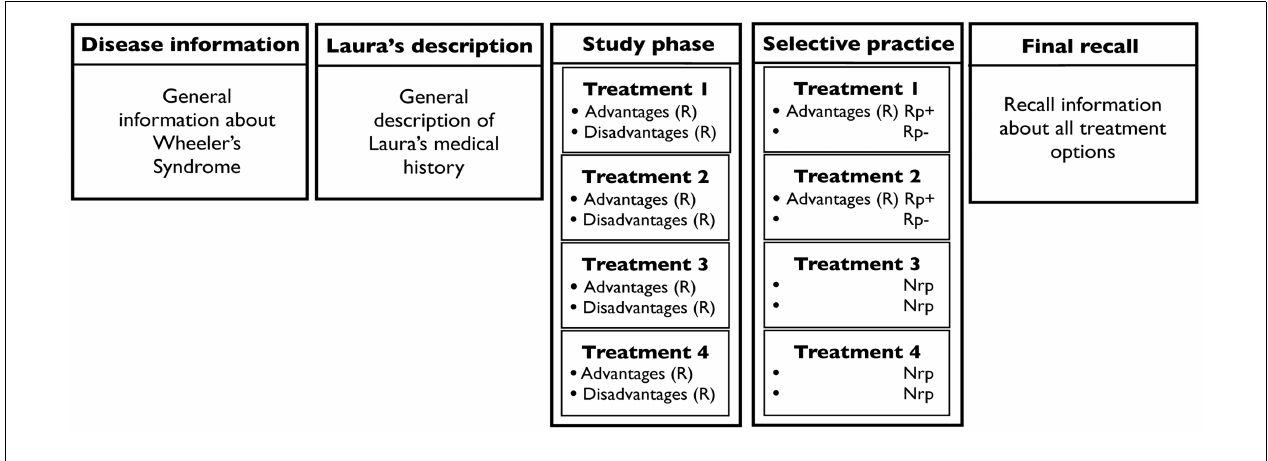
practice minus, and Nrp for no retrieval practice. In the NegativeValence condition, participants selectively practiced relevant disadvantages for two of the four